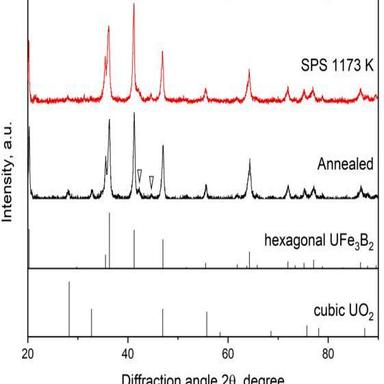
XRD patterns of the UFe3B2 sample after SPS and annealing, with reference patterns for UFe3B2 and UO2.